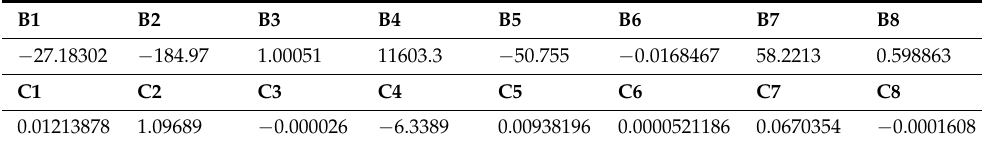
Table 5. Coefficients for desiccant wheel temperature and humidity ratio equations [61].